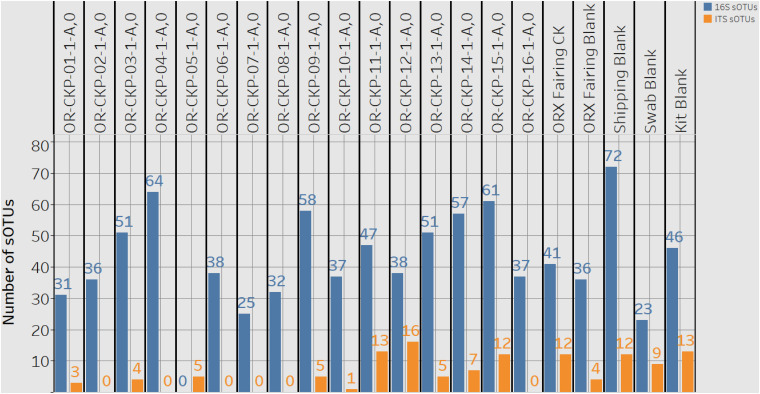
A plot detailing the number of 16S rRNA gene or bacterial sOTUs (blue bars) and ITS or fungal sOTUs identified in each sample. 16S rRNA gene samples with < 5,611 16S rRNA gene sequences are listed as having zero sOTUs. ITS samples with zero sequences also have zero sOTUs.